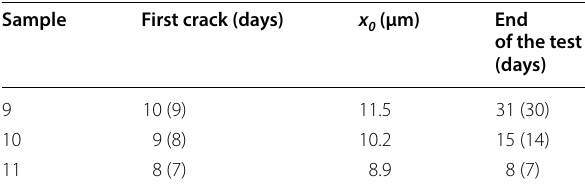
Table 2 Data corresponding to the accelerated corrosion tests conducted on the three reinforced cement mortar